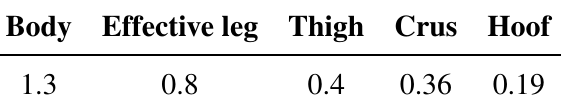
Table 3. Characteristic robot lengths (in meters) based on biomimetism.